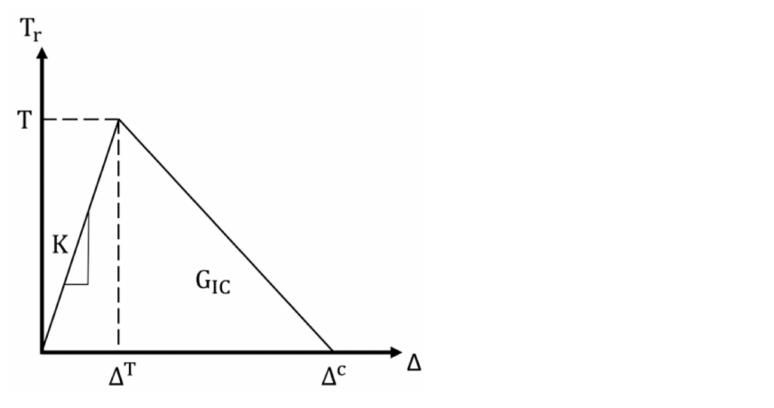
Figure 2. The linear traction–separation law (TSL) used to model damage initiation and evolution of the mode I fracture. This plot represents the c = 1 case of the truncated linear